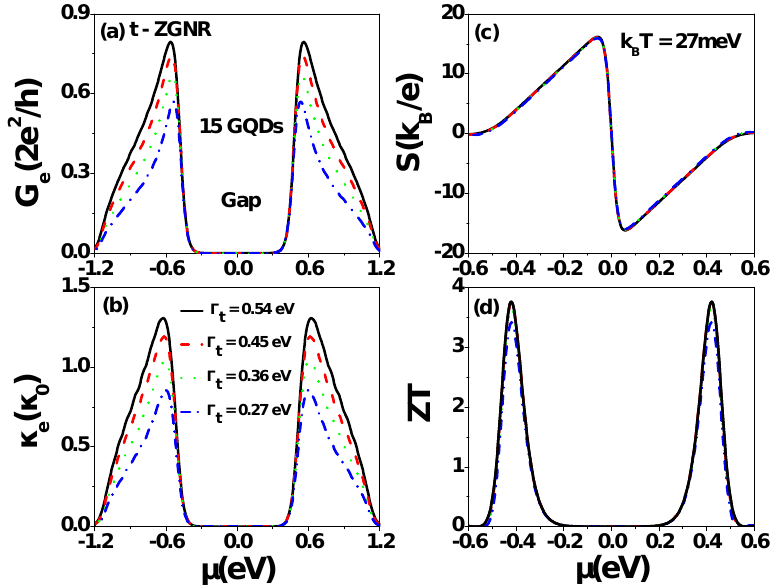
Figure 5. ( a ) Electrical conductance G e , ( b ) electron thermal conductance κ e , ( c ) Seebeck coefficient S , and ( d ) figure of merit ZT as functions of µ for various tunneling rates ( Γ t ) at k B T = 27 meV. The t-ZGNR structure with L z = 14.5 nm considered is illustrated in Figure 1b. The size of each GQD in the t-ZGNR is characterized by N a = 8 and N z =